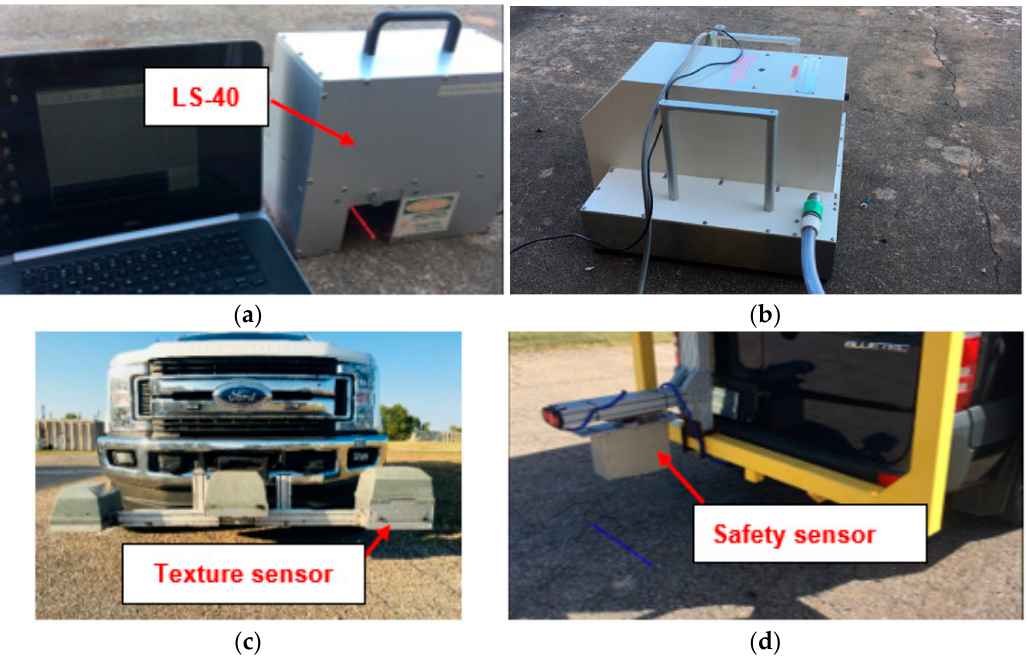
Figure 2. Data collection devices: ( a ) LS-40, ( b ) DFT, ( c ) High-speed texture profiler, and ( d ) Safety